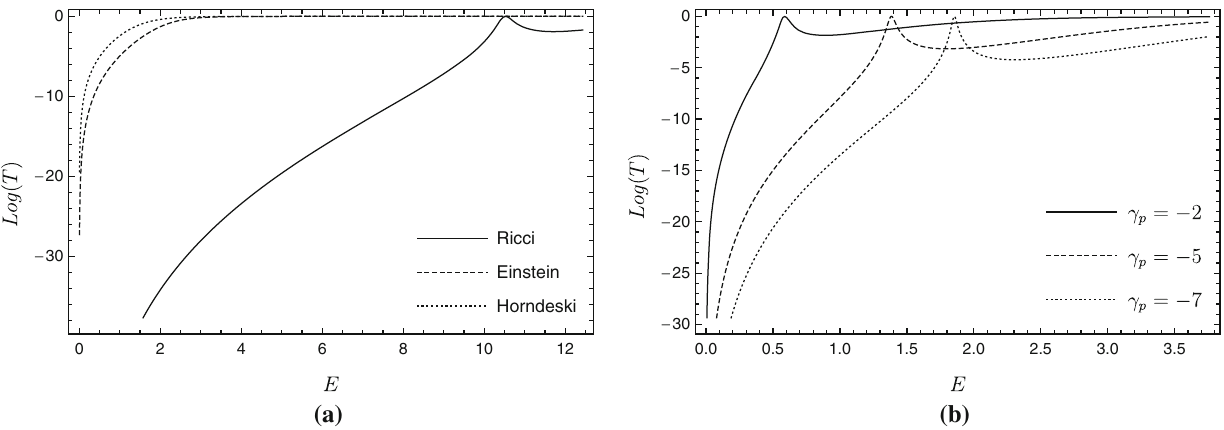
Fig. 11 The transmission coefficient in Randall–Sundrum delta like scenario with k = 1 , D = 10 and p = 3 as function of E = m 2 Einstein, Horndeski and b Riemann